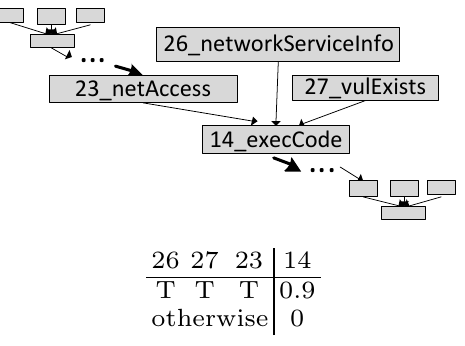
Figure 5. A Portion of Bayesian Network with associated